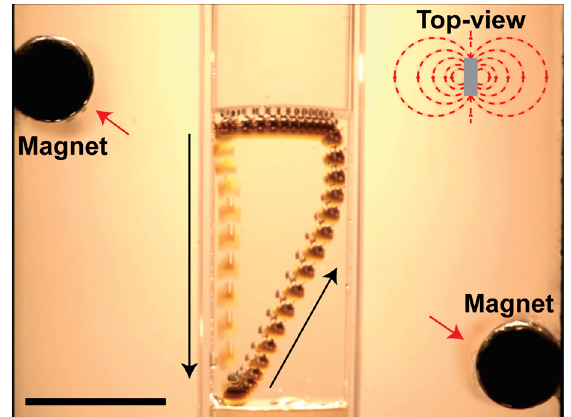
Figure 18. Oscillating elevator supraparticle in a wt% aqueous H 2 O 2 solution. Starting at the top left, the elevator releases the oxygen bubble and falls down to the left bottom. After producing an oxygen bubble, it gets attracted by the bottom right magnet, following this attraction to the right during the way up. Having reached the surface meniscus, the left magnet pulls the elevator supraparticle back to its starting position, restarting the movement cycle; the scale bar is 1 cm. Reprinted with permission from [94] (p. 6). Copyright 2016 Wiley.